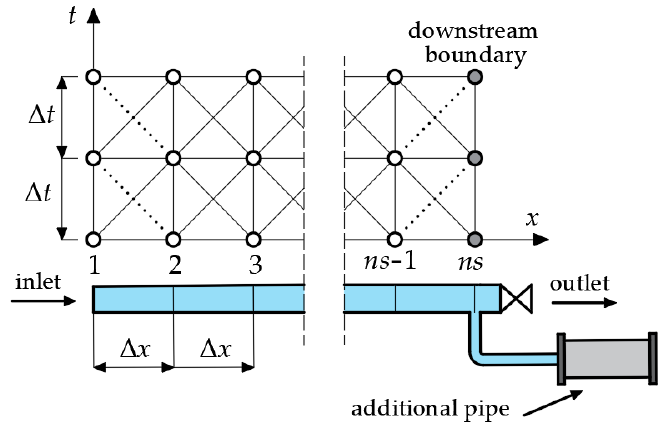
Figure 13. Characteristic grid used in numerical calculations.